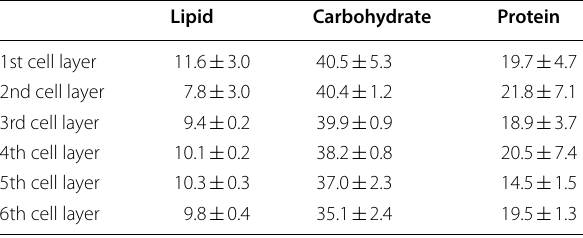
Values are the averages of three replicated experiments,